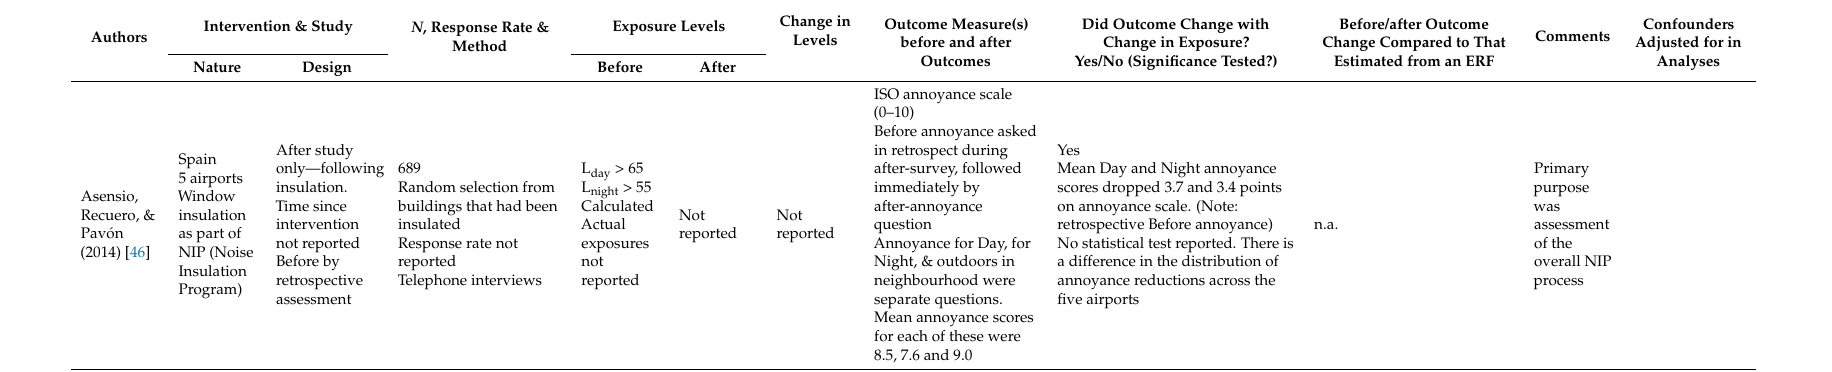
Table 12. Path Interventions (Type